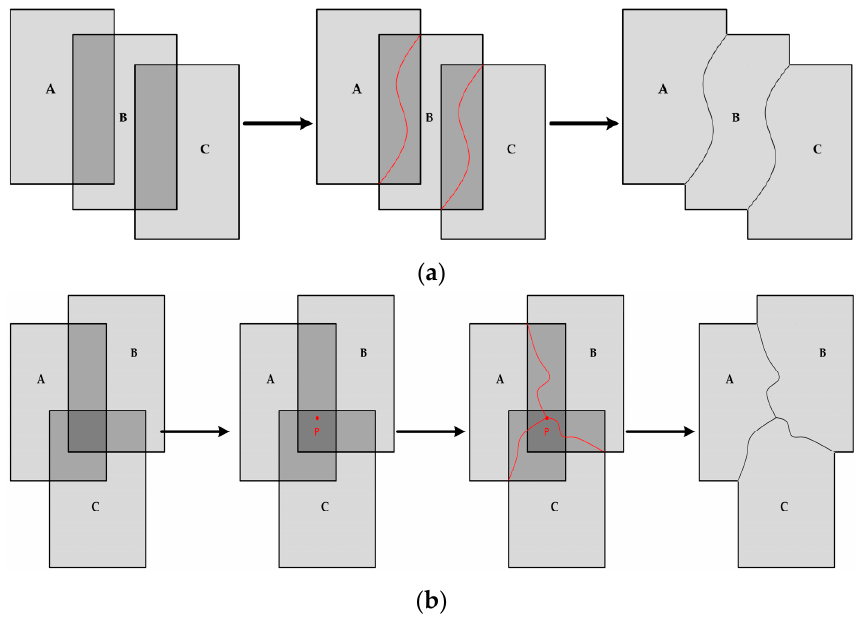
Figure 6. Seamline detection: ( a ) two-image overlap; ( b ) multi-image overlap.